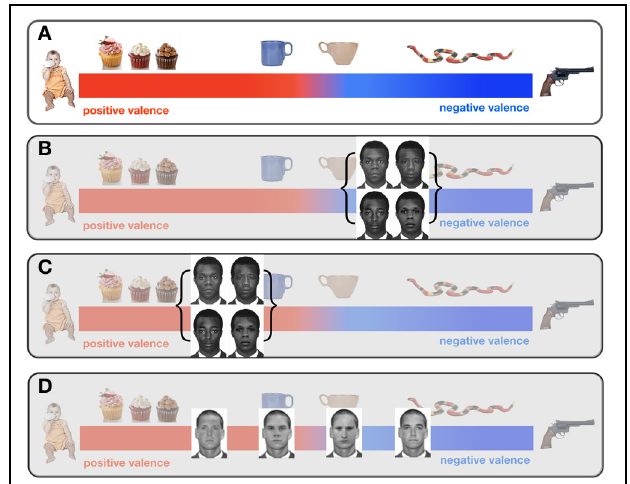
FIGURE 5 | The valence Continuum. The valence continuum (A) illustrates the hypothesis that faces and objects are automatically evaluated with respect to a metric of positive or negative based on affective associations. Valences for faces and objects can be organized on a continuum that ranges from strongly positive to strongly negative. Pre-election, on average, black faces elicited negative associations—supported by black faces priming negative words more so than positive words. As illustrated in (B) , this posits that, pre-election, black faces were clustered at the negative end of the valence continuum. Note that this clustering is, at least in part, a product of the ORE, namely that for the majority of Caucasian participants black faces look more similar to one another as compared to white faces. Thus, the affective associations and concomitant implicit biases overlap for Caucasians encountering African-Americans. (C) Notably for US participants only the position of this cluster shifts to the positive end of the continuum post-election, as suggested the data reported in this paper. (D) Similar clustering would not seen for Caucasian participants looking at white face primes in that participants are better able to perceptually discriminate between own-race faces, and so associate individual primes with lower overlapping valences. This greater variability in valence for own-race individuals may help account for why we observed a more consistent positive association with black faces as compared to white faces for participants in